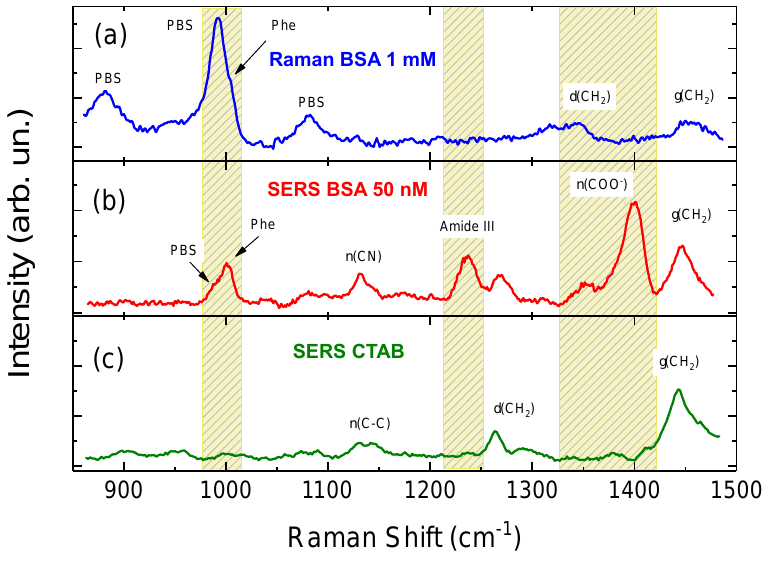
Figure 2 . ( a ) Raman spectrum of BSA 1 mM in PB (laser power 6.5 mW, integration 30 s). ( b ) SERS spectrum of BSA 50 nM in PB (laser power 6.5 mW, integration 30 s). ( c ) SERS signal detected on NRs precipitated in absence of protein, attributed to the residual CTAB (laser power 2 mW, integration 120 s).